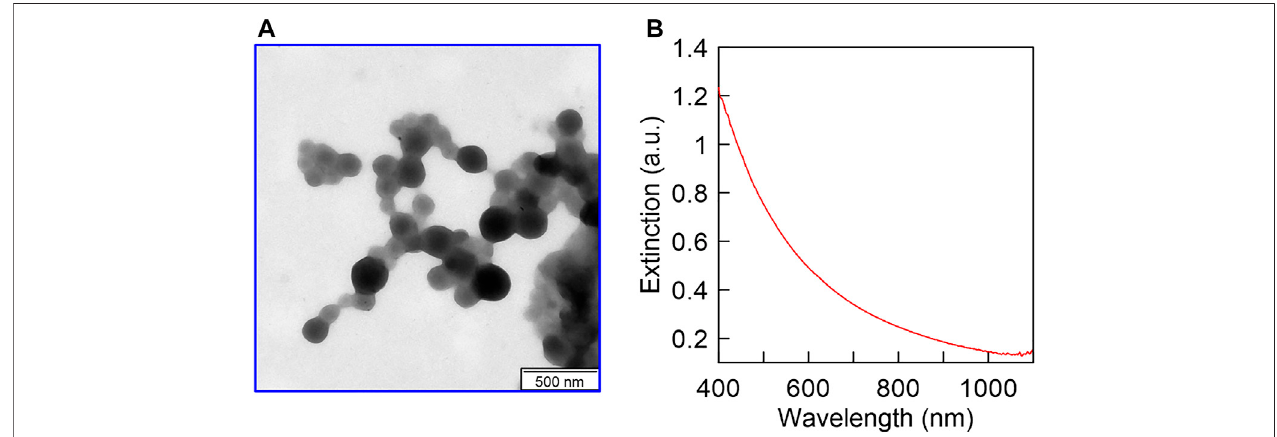
FIGURE 2 | The TEM image (A) and extinction spectrum (B) of the synthesized HSA nanoparticles.